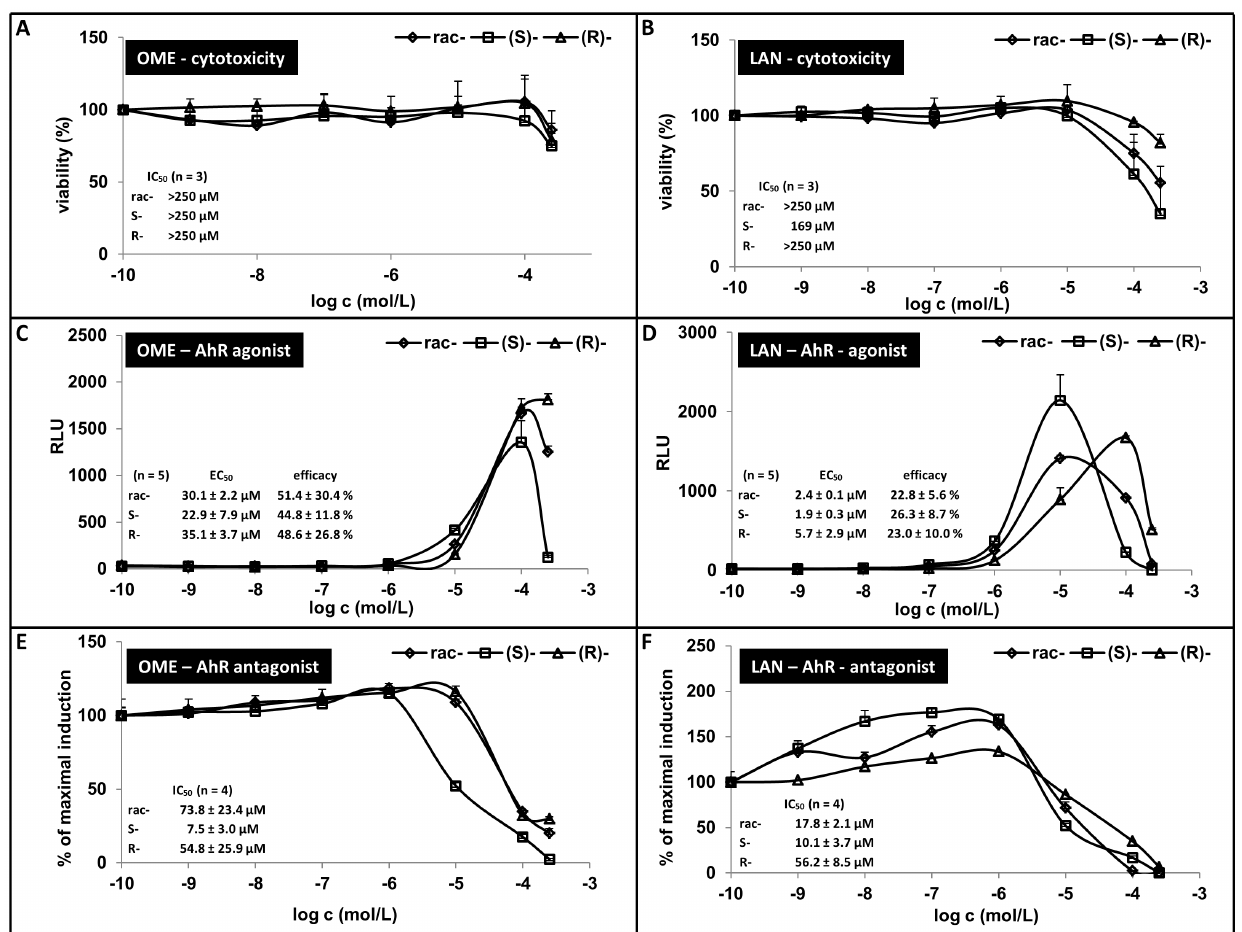
Figure 1. Effect of omeprazole and lansoprazole enantiomers on transcriptional activity of aryl hydrocarbon receptor AhR in human gene reporter cell line AZ-AHR. The cells were seeded in 96-well plates and stabilized for 16 h. Panels A and B: Cells were incubated for 24 h with S-OME, R-OME, rac-OME, S-LAN, R-LAN and rac-LAN at concentrations ranging from 10 2 10 M to 10 2 4 M. The vehicle was DMSO (0.1% v/v). After the treatment, MTT test was performed and absorbance was measured at 540 nm. Treatments were performed in triplicates. The data are the mean from experiments from six different passages of cells and are expressed as a percentage of viability of control cells. The values of IC 50 were calculated and are indicated in a figure. Panels C - F: AZ-AHR cells were incubated for 24 h with S-OME, R-OME, rac-OME, S-LAN, R-LAN and rac-LAN at concentrations ranging from 10 2 10 M to 10 2 4 M in the absence (Panels C and D - agonist mode ) or in the presence (Panels E and F- antagonist mode ) of TCDD (5 nM). The vehicle was DMSO (0.1% v/v). After the treatments, cells were lysed and luciferase activity was measured. Treatments were performed in triplicates in five ( agonist mode ) or four ( antagonist mode ) independent cell passages. Representative gene reporter assays are showed. Data are expressed as a fold induction of luciferase activity over control cells (Panels C and D - agonist mode ) or as a percentage of maximal induction attained by TCDD (Panels E and F- antagonist mode ). The values of EC 50 and IC 50 were calculated and the average values are indicated in figures.